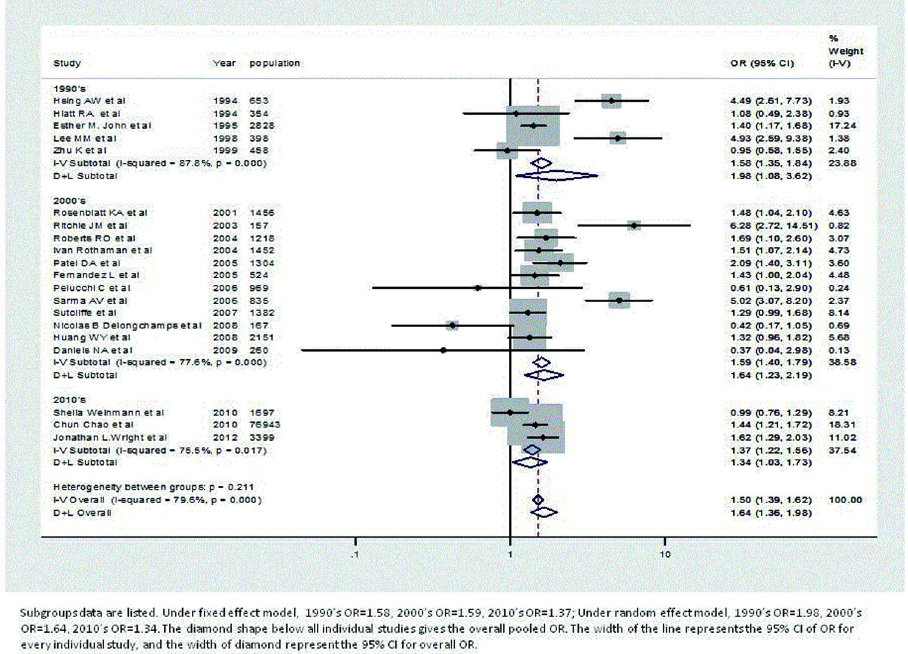
Figure 4. Forest plot of odds ratio under fixed effect and random effects model, based on decades. doi: